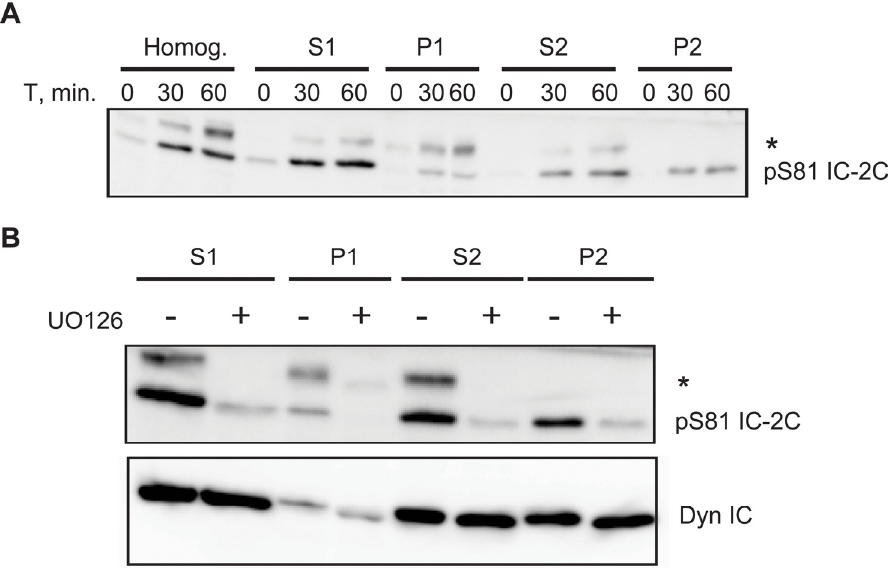
Figure 6. ( A ) Phospho S81 IC-2C fractionates with membrane bound organelles. Serum-starved REF cells were left untreated or stimulated with EGF for 30 or 60